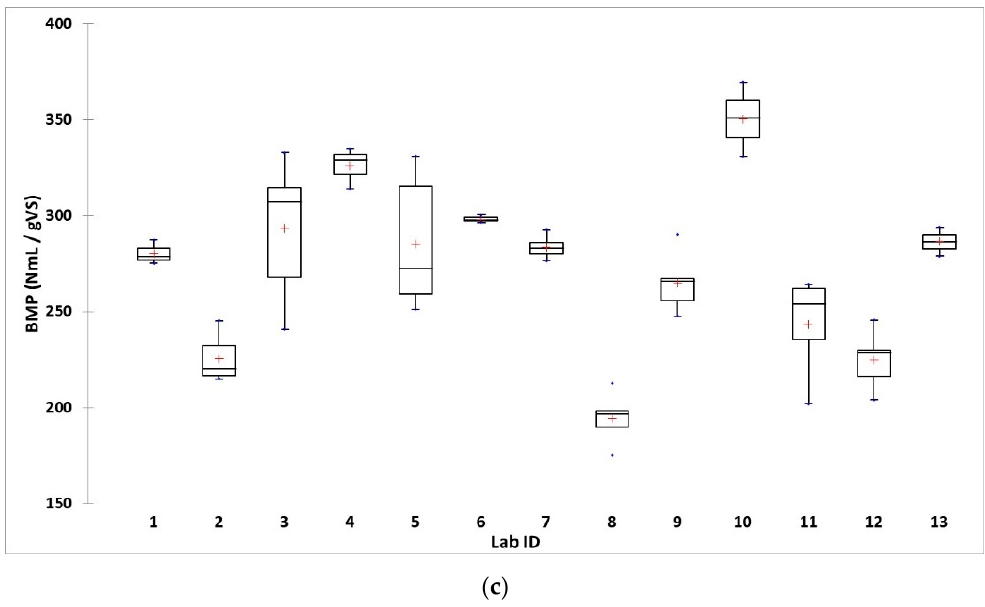
Figure 5. Box plots for the results of the first phase—free protocols: ( a ) SA; ( b ) SA’; ( c ) SB.